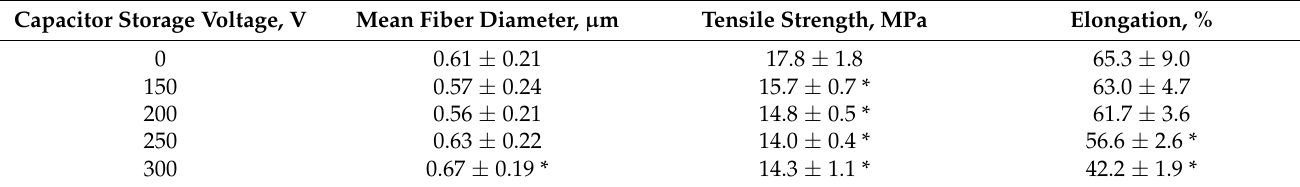
Table 1. Average fiber diameter and mechanical characteristics of the membranes modified under various